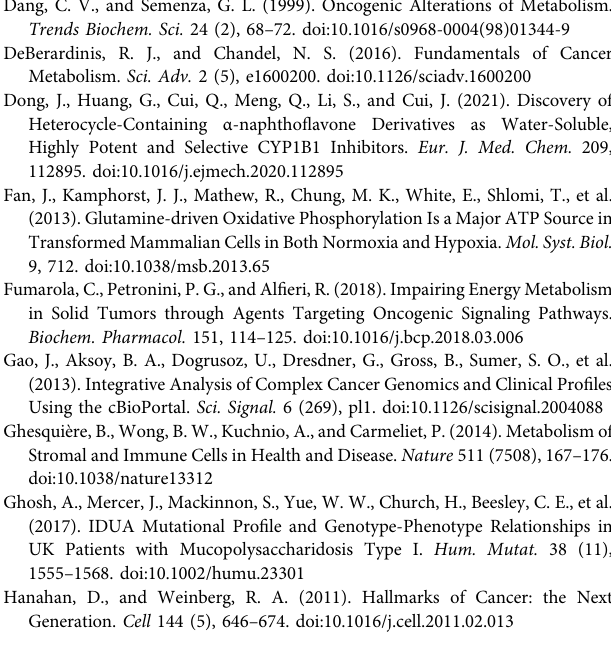
Supplementary Figure S1 | Consensus clustering matrix of 408 samples from TCGA dataset for k =3 (A) , 4 (B) , 5 (C) , and 6 (D) . Kaplan – Meier curve of progression-free survival of patients with BLCA in two clusters (E) . Cumulative distribution function (CDF) plot of consensus clustering for k = 2 to k = 6 (F) . Supplementary Figure S2 | GSEA of cluster-correlated gene sets with the top normalized enrichment score (NES) score through Joy Plot. Supplementary Figure S3 | Survival curves of ferroptosis-related genes on overall survival in patients with BLCA. Supplementary Figure S4 | Spearman correlation analysis of the energy metabolism-related gene risk score and immune in fi ltration level, including B cells (A) , CD4+ T cells (B) , CD8+ T cells (C) , neutrophils (D) , macrophages (E) , and myeloid dendritic cells (F) . Supplementary Figure S5 | Venn diagram identi fi es 162 prognostic energy metabolism-related genes that were differentially expressed between cluster 1 and cluster 2 (A) . Col1: 3568 genes that were differentially expressed between clusters Col2: 590 metabolism-related genes. Venn diagram identi fi es 67 differentially expressed energy metabolism-related genes that are signi fi cantly correlated with overall survival (B) . Col1: 162 metabolism-related genes that were differentially expressed between clusters 1 and 2. Col2: 157 metabolism- related genes were correlated with overall survival ( p < 0.1). Supplementary Figure S6 | Survival curves of 16 genes involved in the prognostic